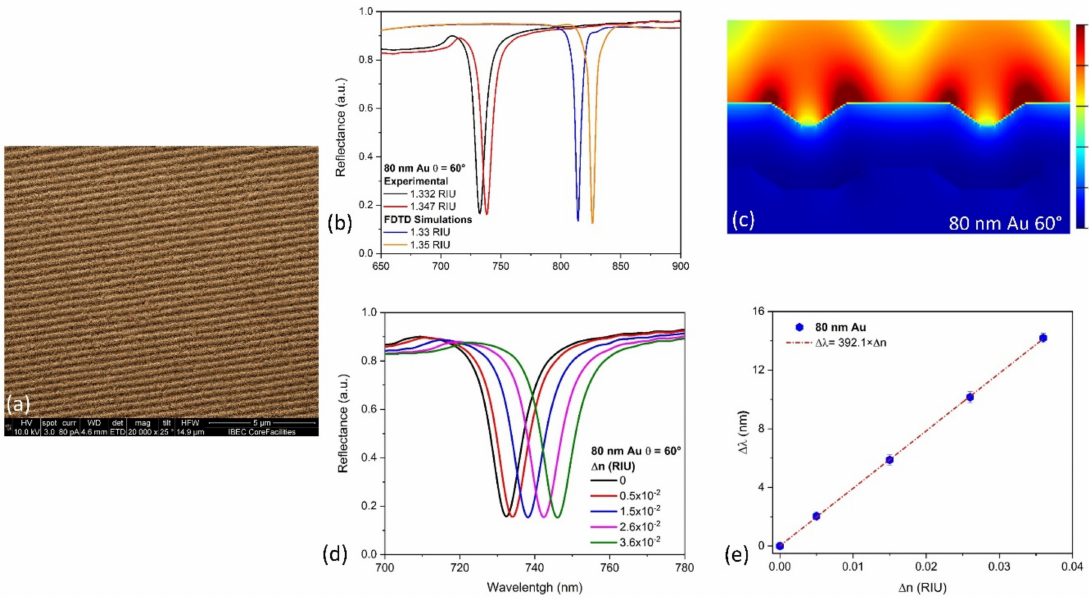
Figure 3. FDTD simulations of the proposed sensor and sensing performance evaluation. ( a ) SEM photographofthefabricatedplasmonicnanogratings.( b )Experimentalandsimulatedopticalreflectance spectra under TM-polarization with a light incident angle of 60 ◦ for the nanostructured plasmonic sensor fabricated. ( c ) Simulated electric field distribution for the 80 nm gold thickness layer on the polycarbonate nanograting under TM-polarization for a light incidence angle of 60 ◦ . ( d ) Displacement of the reflectance spectra for the plasmonic nanogratings based sensor fabricated with di ff erent refractive index solutions based on ethanol-water mixtures. ( e ) Calibration curve and bulk sensitivity determination for the 80 nm gold thickness layer sensor at a light incidence angle of 60 ◦